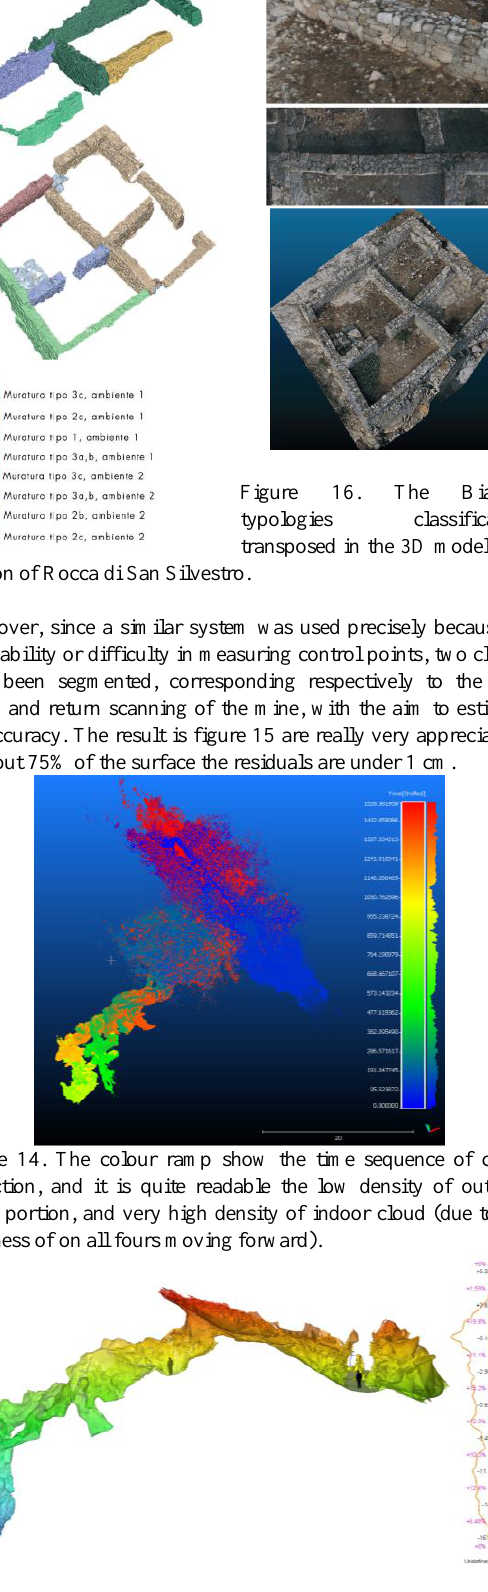
Figure 15. Comparison between two clouds corresponding to the first round and return scanning; residuals are very low for most of the surface. (under or near